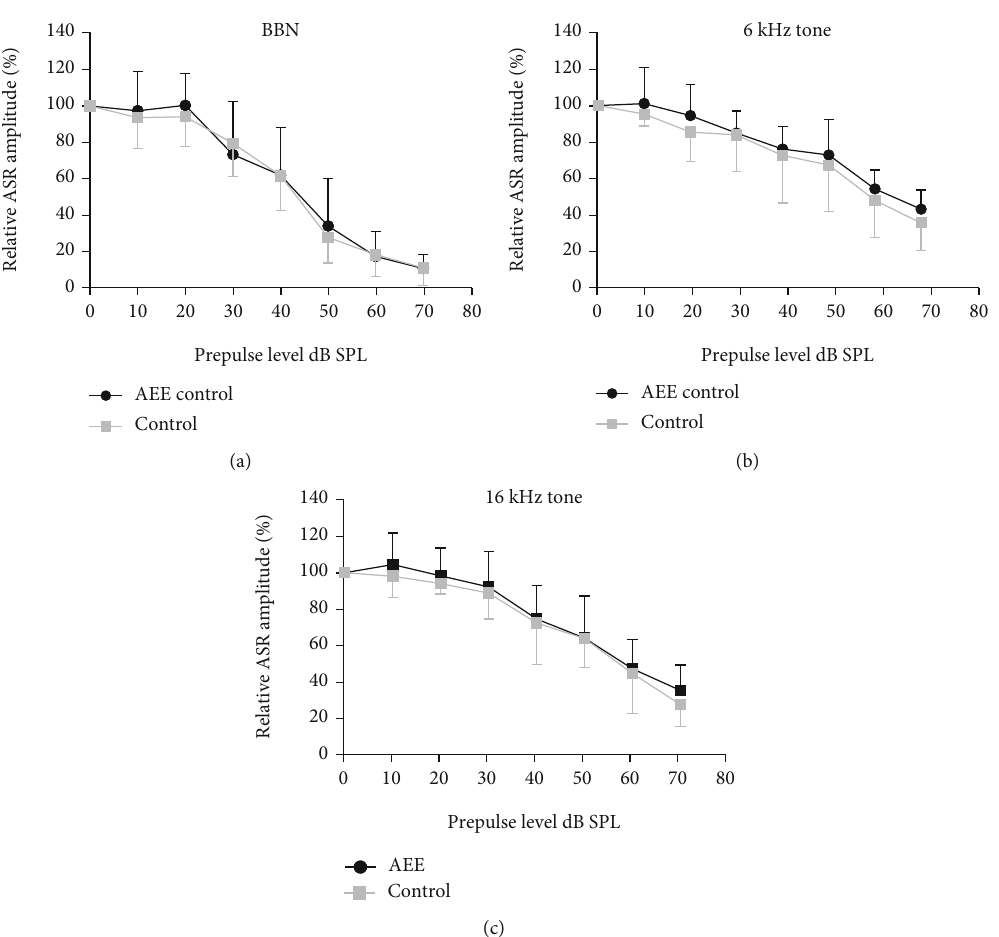
Figure 3: The comparison of PPI of ASR induced by sounds of di ff erent intensities in enriched and control rats ( mean ± SD ): (a) BBN prepulse; (b) 6kHz prepulse; (c) 16kHz prepulse; 100% corresponds to the ASR amplitude without prepulse. The curves in each panel are not statistically di ff erent ( p = 0 : 77 , p = 0 : 31 , and p = 0 : 34 , resp., RM two-way